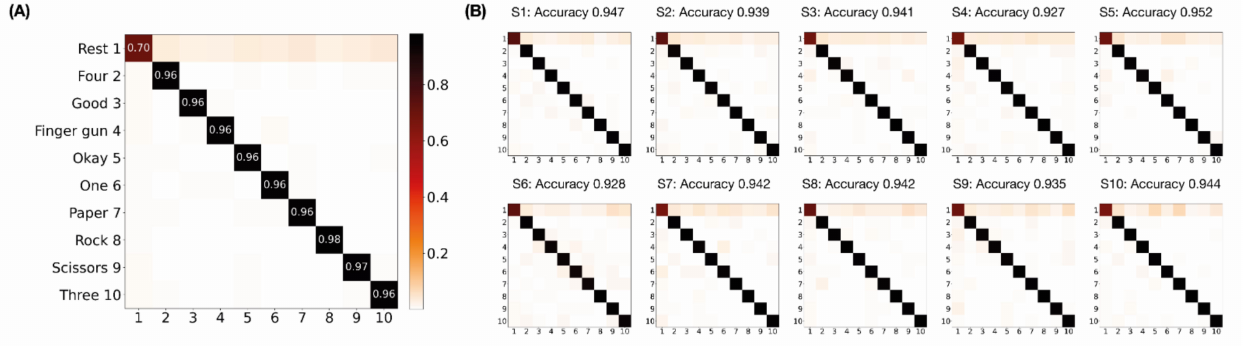
Figure 9. Confusion matrices of ANN-based classifiers in the test datasets. True and predicted labels are shown on the horizontal and vertical axes, respectively. ( A ) Average of all subjects. ( B ) Indiv- idual